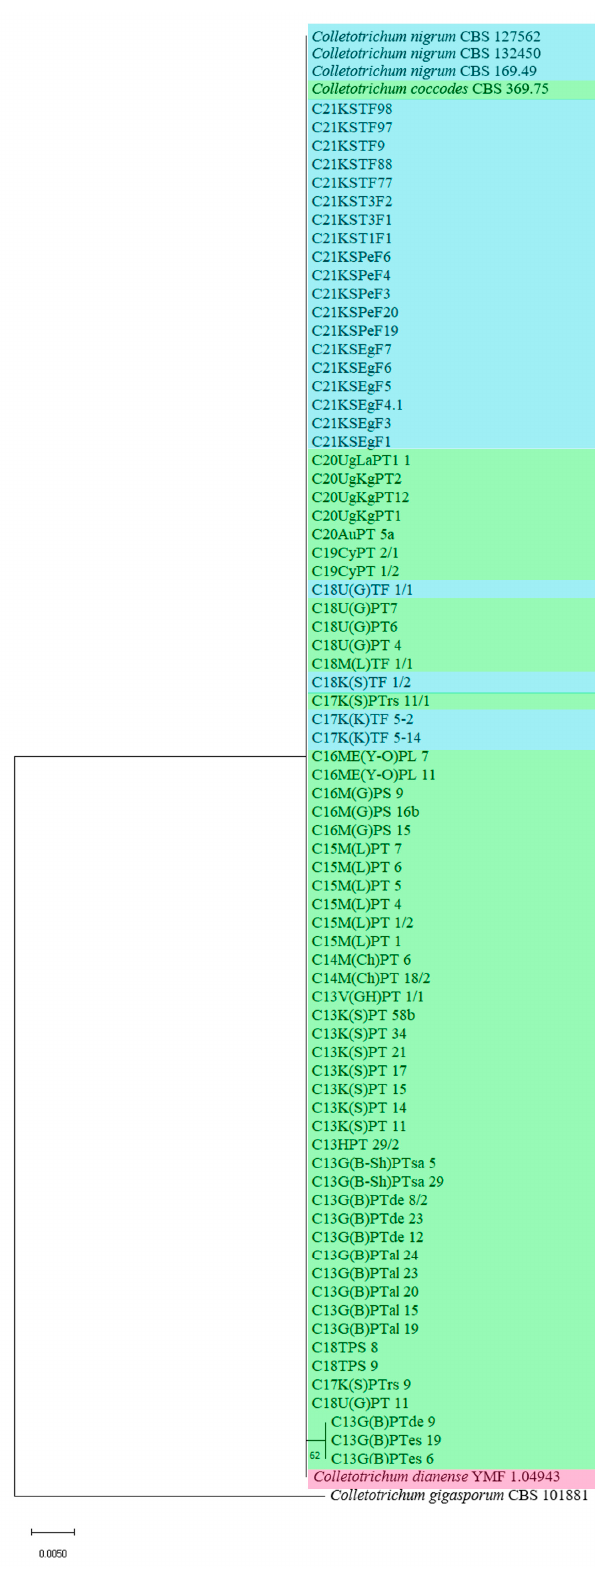
Figure 3. Phylogenetic tree inferred from maximum-likelihood analysis of the ITS1-5, 8S-ITS2 region alignment. Bootstrap 1000 replicates. The confidence values are indicated at the branches. Green indicates C. coccodes isolates; blue indicates C. nigrum isolates, and red marks C. dianense type species.